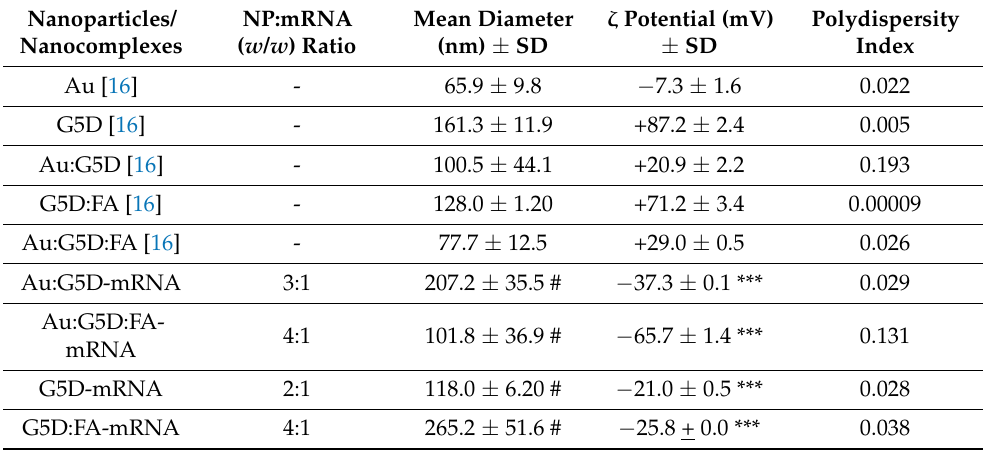
Figure 3. TEM micrograph of ( A ) AuNPs, ( B ) Au:G5D, ( C ) Au:G5D-mRNA nanocomplex, ( D ) Au:G5D:FA, and ( E ) Au:G5D:FA-mRNA nanocomplex. Nanocomplexes were prepared at optimum binding ratios of 3:1 ( w / w ) for Au:G5D-mRNA and 4:1 ( w / w ) for Au:G5D:FA-mRNA, respectively. Table 1. Hydrodynamic size, ζ potential measurements, and polydispersity indices of nanoparticles and nanocomplexes. Data are presented as mean diameter ± standard deviation (SD) ( n =